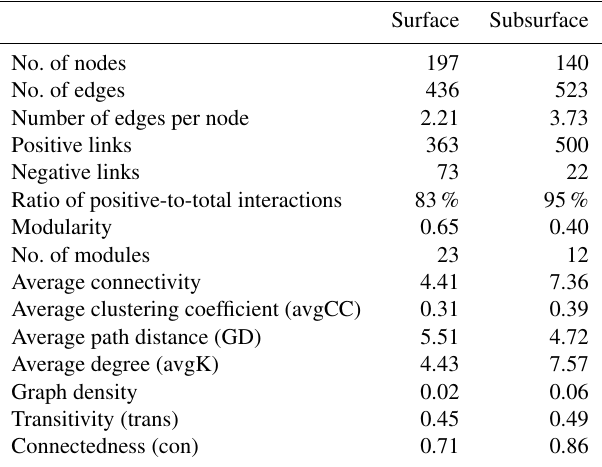
Table 2. Topological properties of the empirical networks for the surface and subsurface bacterial